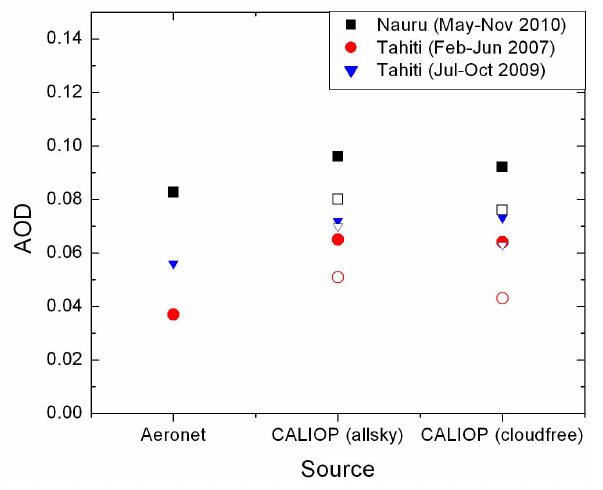
Fig. 15. Co-located HSRL and CALIOP nighttime 532nm extinc- tion